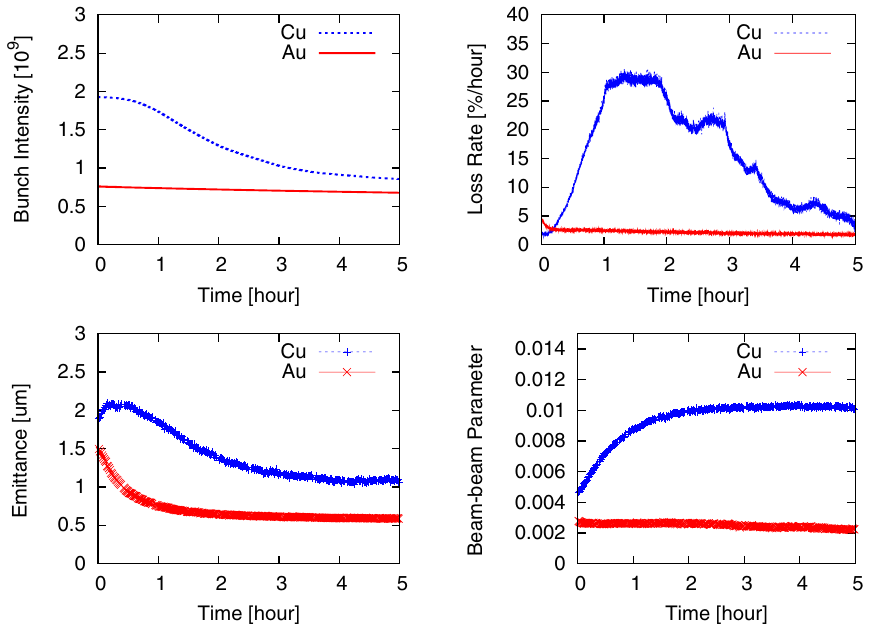
FIG. 13. One fill in the 2012 RHIC 100 GeV asymmetric Cu-Au run with full gains of 3-d cooling. Large beam loss was observed between 1 to 4 hours into store. Top left: bunch intensities. Top right: beam loss rates. Bottom left: normalized transverse emittances. Bottom right: total beam-beam parameters with 2 collisions per